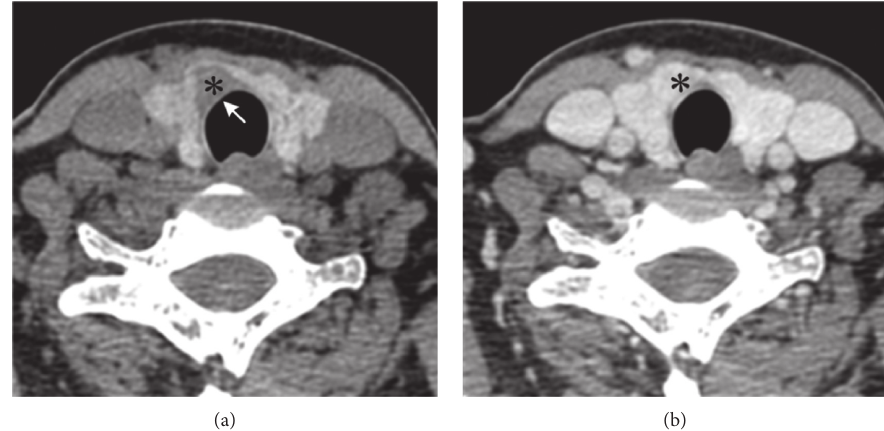
Figure 3: Right thyroid lobe near isthmus showing a low-density nodule ( ∗ ), in a female, 39 years old. (a) Thyroid marginal interruption with “marginal defect sign” ( ↑ ). (b) The enhancement in blur sign and the decrease in the density difference between the lesion and the normal thyroid gland. The pathological diagnosis is